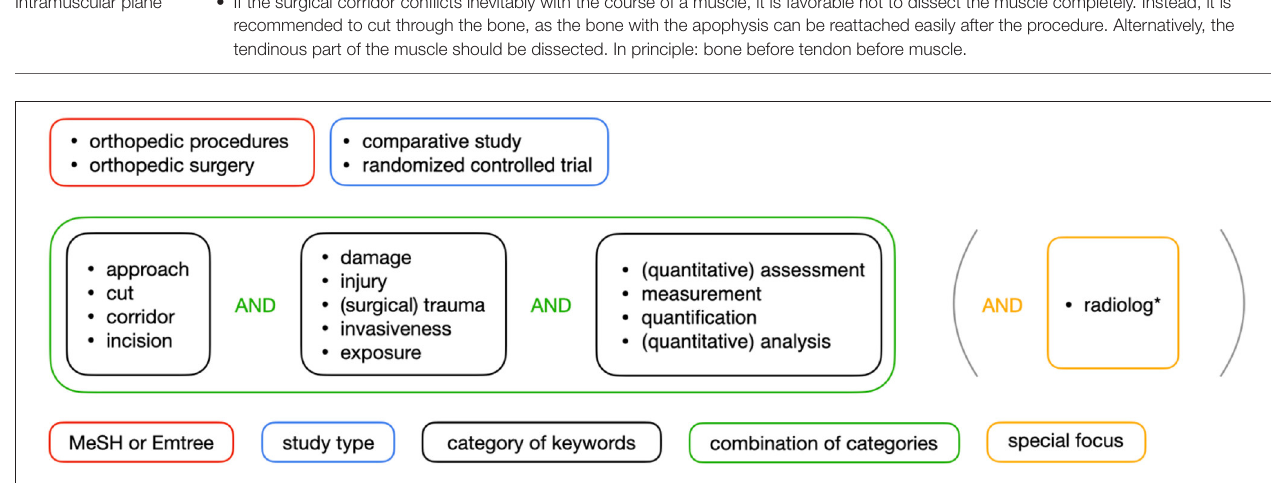
FIGURE 1 | Illustration of the search